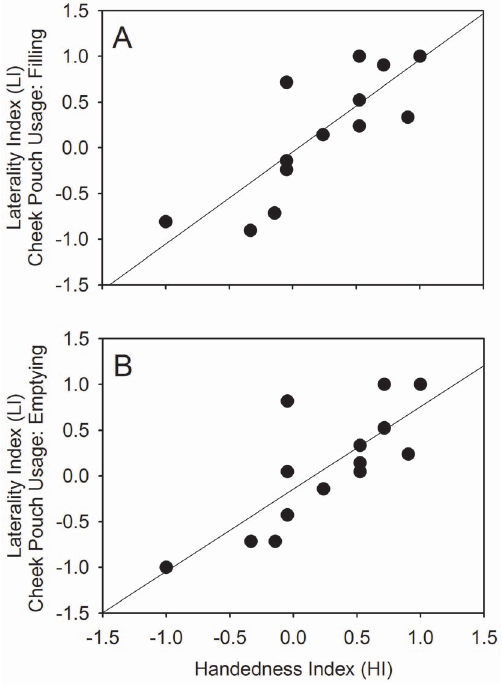
Figure 1. Relationship between Hand and Cheek Pouch Usage among the Macaques (n=14): while Filling (A) and Emptying (B).